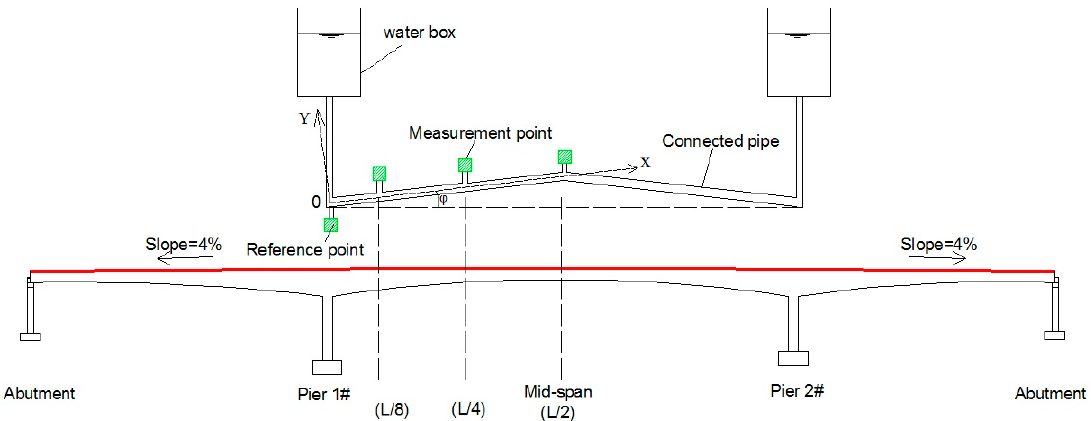
Figure 1. Layout of the straight-line-type liquid level sensing system (LLSS).